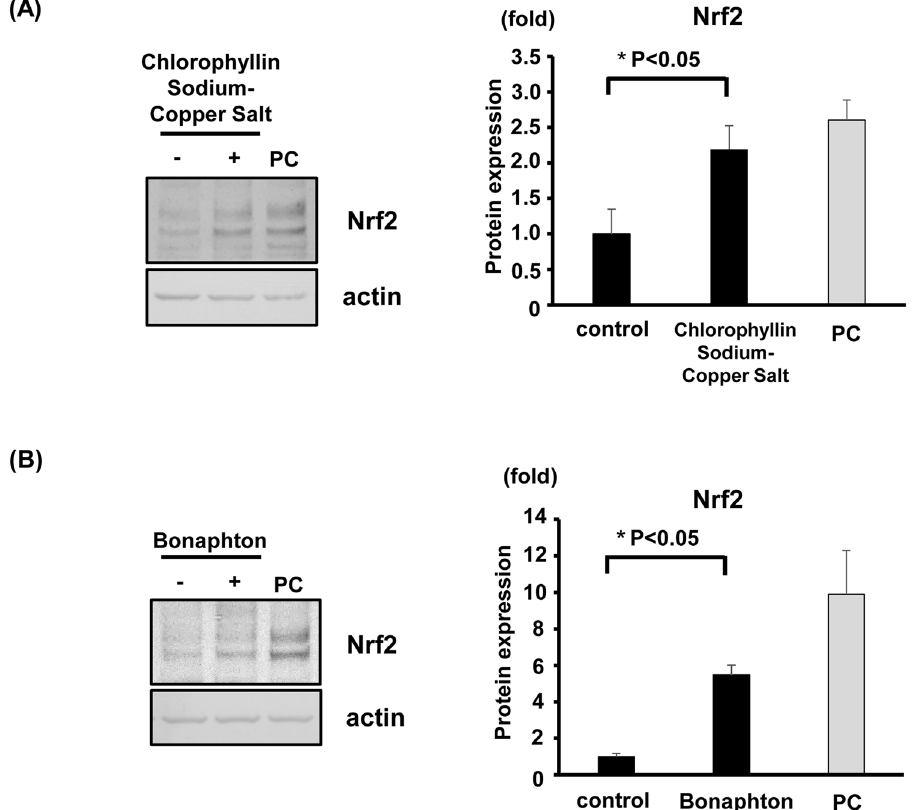
Figure 4. Nrf2 protein expression in HepG2 cells is enhanced by chlorophyllin sodium copper salt and bonaphton. HepG2 cells were treated with the two compounds for 5 h. Sulforaphane, a known Nrf2 activator, was used as a positive control (5 μ M; PC). Total cell lysates were immunoblotted using the Nrf2 antibody. ( A ) Chlorophyllin sodium copper salt (100 μ M) increased Nrf2 protein expression. ( B ) Bonaphton (100 μ M) increased Nrf2 protein expression. Values are presented as the mean ± S.E.M. * p < 0.05 vs. vehicle-treated cells, t-test (n = 4 per experimental group). Experiments were repeated four times with consistent results, and a representative blot is shown. Full-length blots are presented in Supplementary Fig.